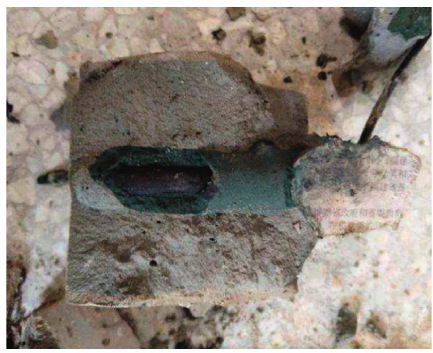
Figure 9: Removing the steel bar after breaking the cement soil sample.